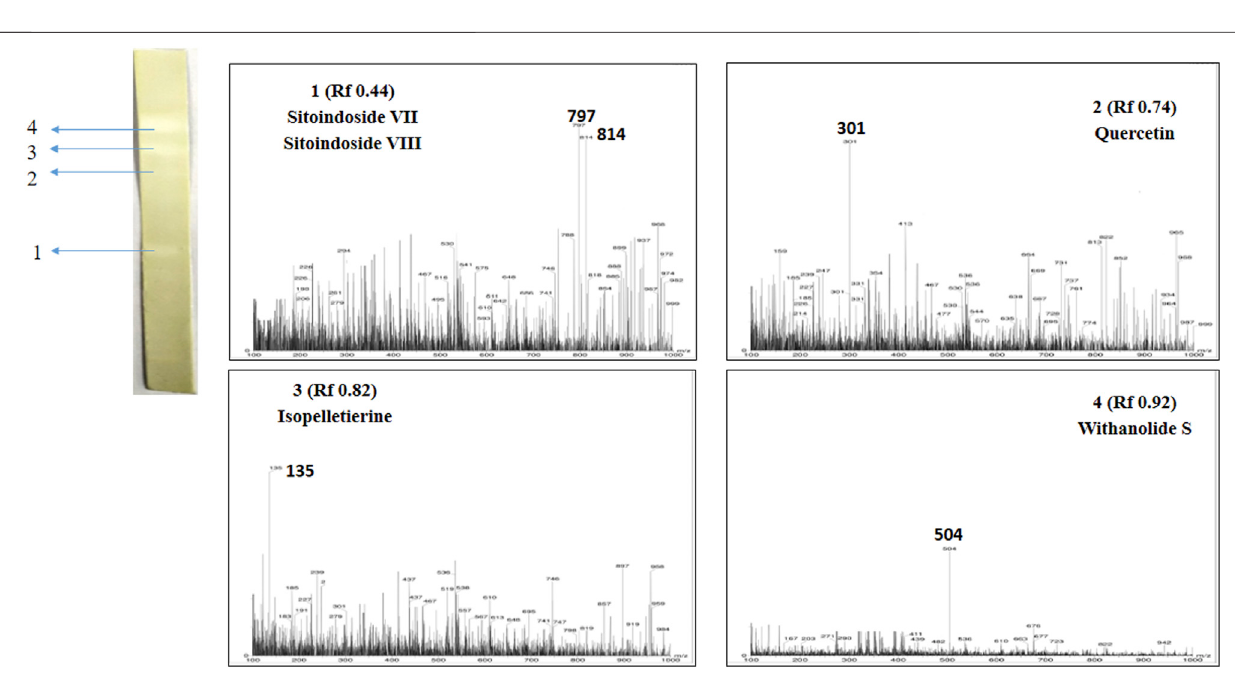
Figure S2 ) at R f 0.17, 0.61, 0.66, 0.78, and 0.81. The isolated